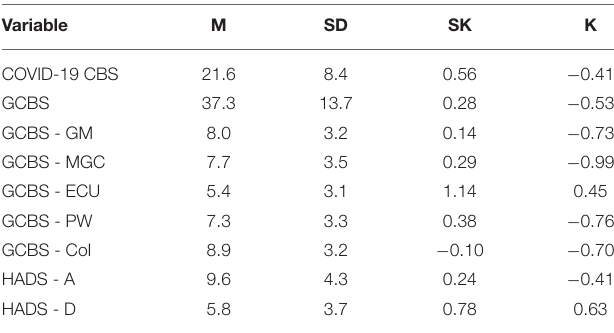
TABLE 2 | Descriptive statistics of the variables for surveyed group of poles ( N =